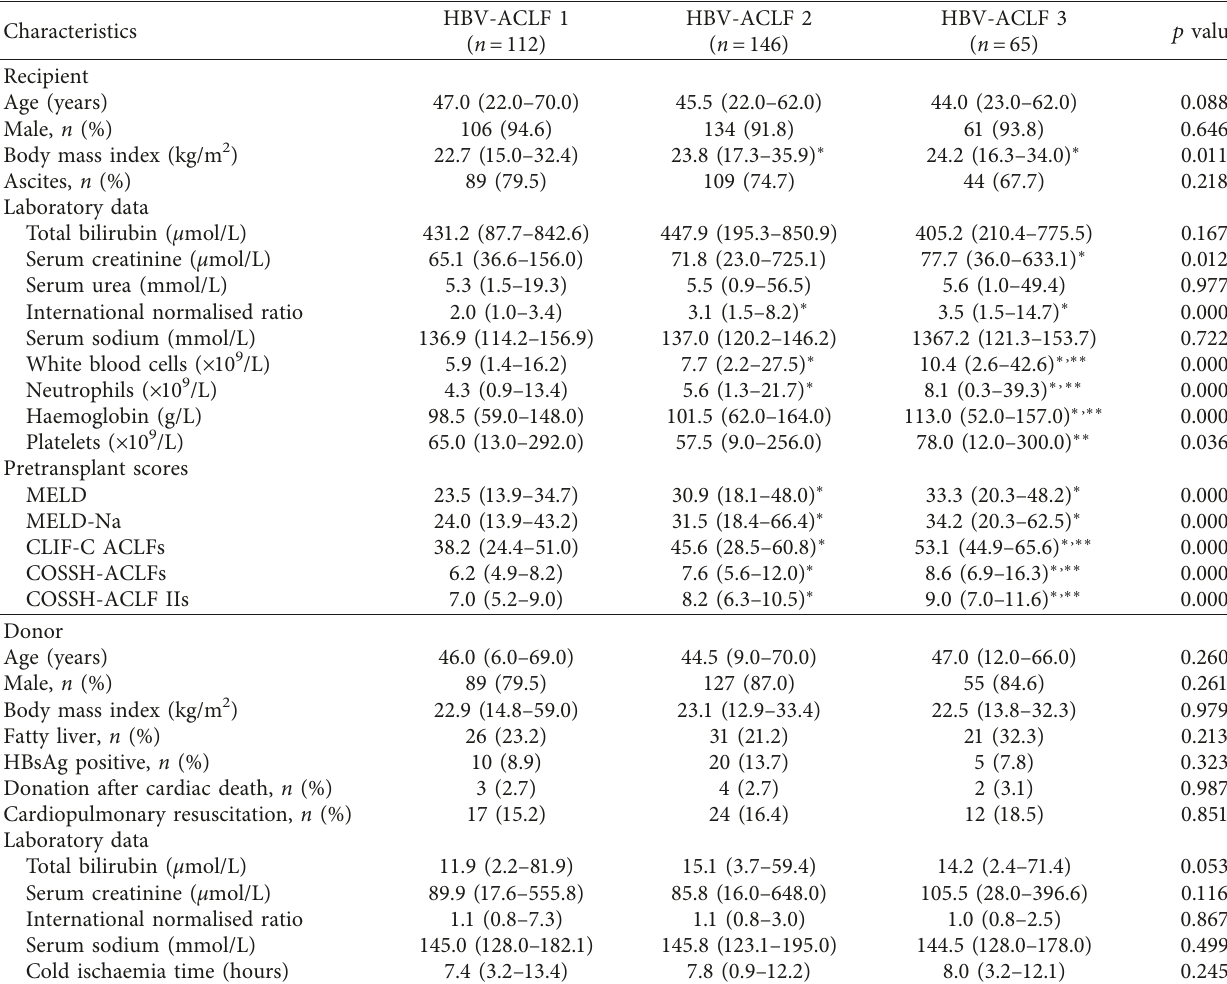
Abbreviations: MELD, model for end-stage liver disease score; MELD-Na, MELD-sodium score; CLIF-C ACLF, chronic liver failure-consortium ACLF score; COSSH-ACLF, Chinese group on the study of severe hepatitis B-ACLF score; COSSH-ACLF II, Chinese group on the study of severe hepatitis B-ACLF